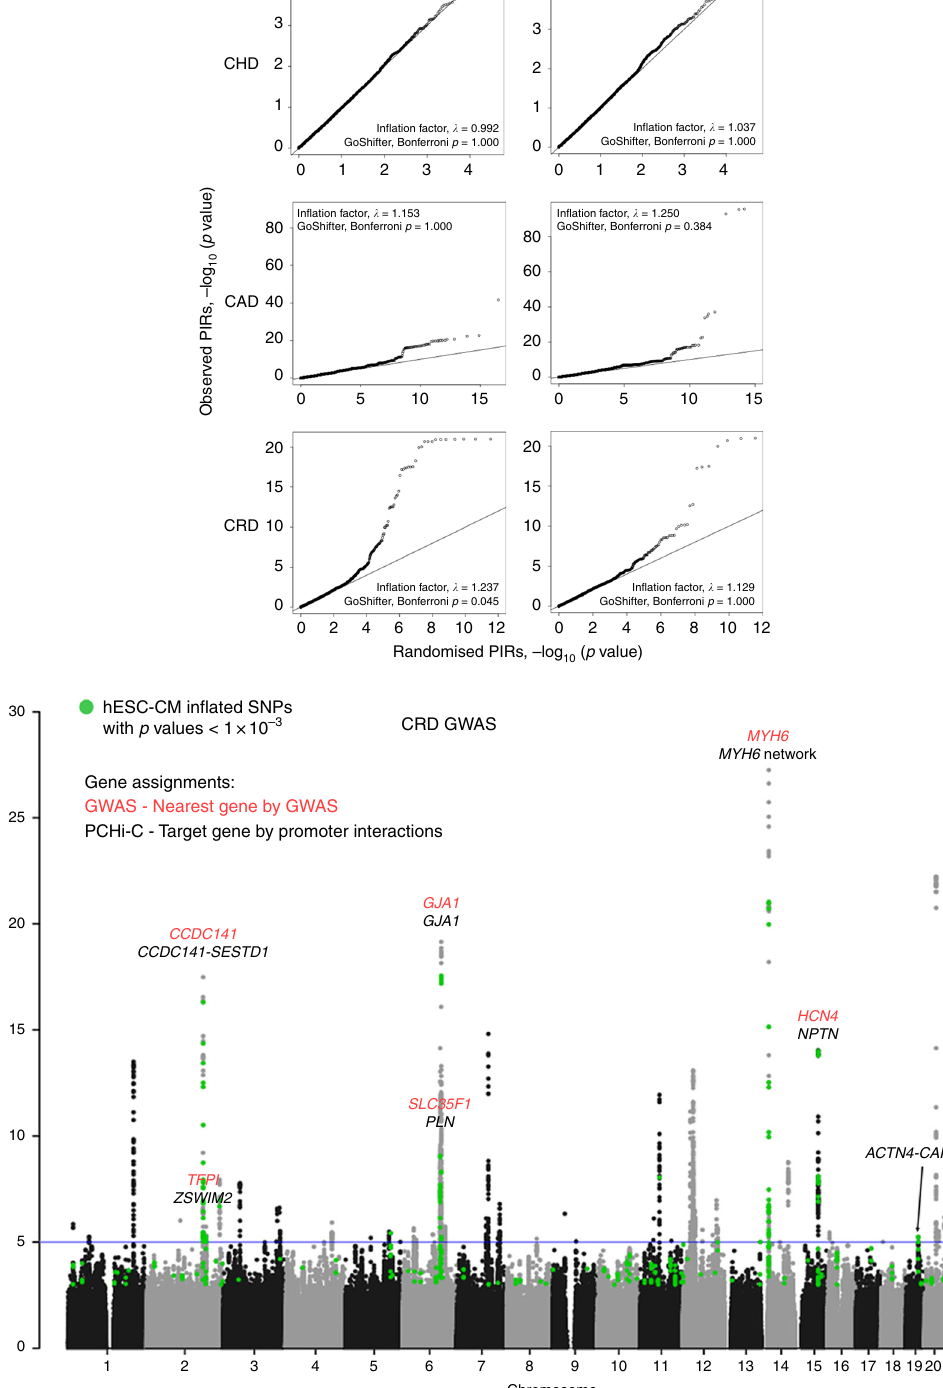
Fig. 5 Association of hESC-CM promoter interactions with cardiac conduction and rhythm disorders. a QQ plots of – log 10 ( p values) corresponding to SNPs located in the top 20% cPIR or hESC PIRs of three GWAS studies, congenital heart disease 25, 26 (CHD; total SNPs = 500K; hESC-CM SNPs = 19K; hESC SNPs = 19K), coronary artery disease 26 (CAD; total SNPs = 9.5 M; hESC-CM SNPs = 289K; hESC SNPs = 328K; http://www.cardiogramplusc4d.org) and cardiac conduction and rhythm disorders 27 (CRD; total SNPs = 2.5 M; hESC-CM SNPs = 85K; hESC SNPs = 80K), against randomised PIRs (average of 1000 permutations). Signi fi cance of overlaps between GWAS SNPs ( p < 0.001) and the top 20% cPIRs or hESC PIRs were tested using GoShifter 28 . b Manhattan plot of CRD GWAS 27 . Green spots indicate in fl ated SNPs in the cPIR/randomised PIR QQ plot with p < 0.001. Red gene names are nearest genes to the SNPs in the signi fi cant peaks assigned by the GWAS and black gene names are target genes interacting with the cPIRs containing the signi fi cant SNPs ( p < 1 × 10 − 5